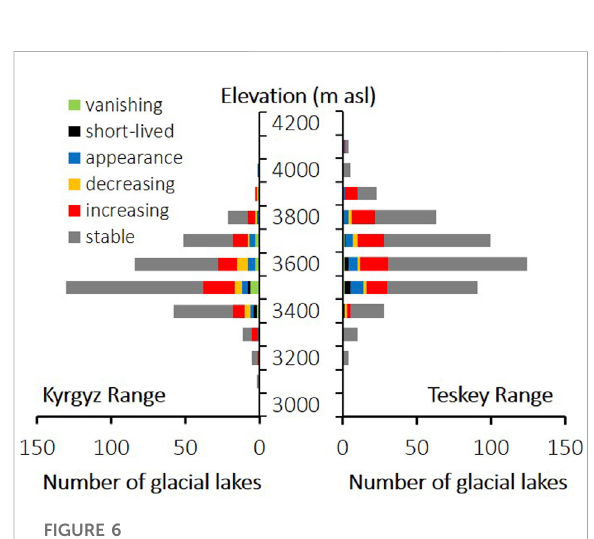
FIGURE 6 A variation in glacial lake dynamics by elevation between 2017 and 2019 in the study